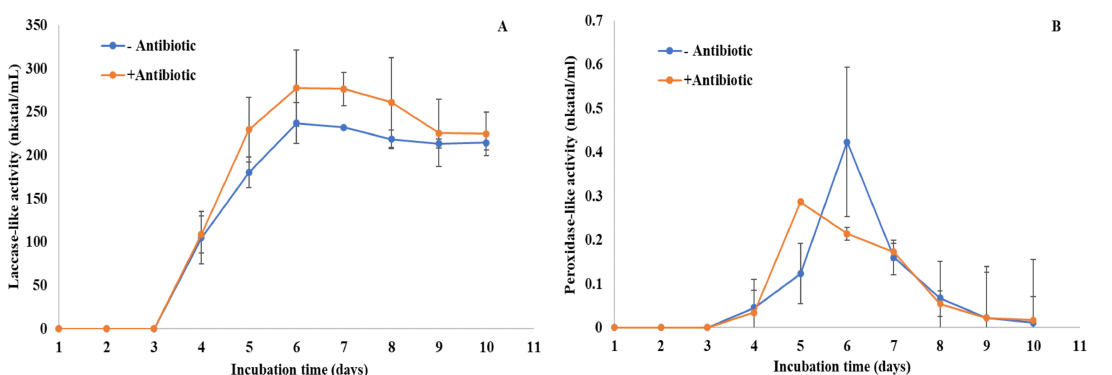
Figure 4. Laccase-like activity ( A ) and peroxidase-like activity ( B ) for both conditions: with or without antibiotic (levofloxacin). Each datapoint (mean ± standard deviation) is the result of tripli- cate